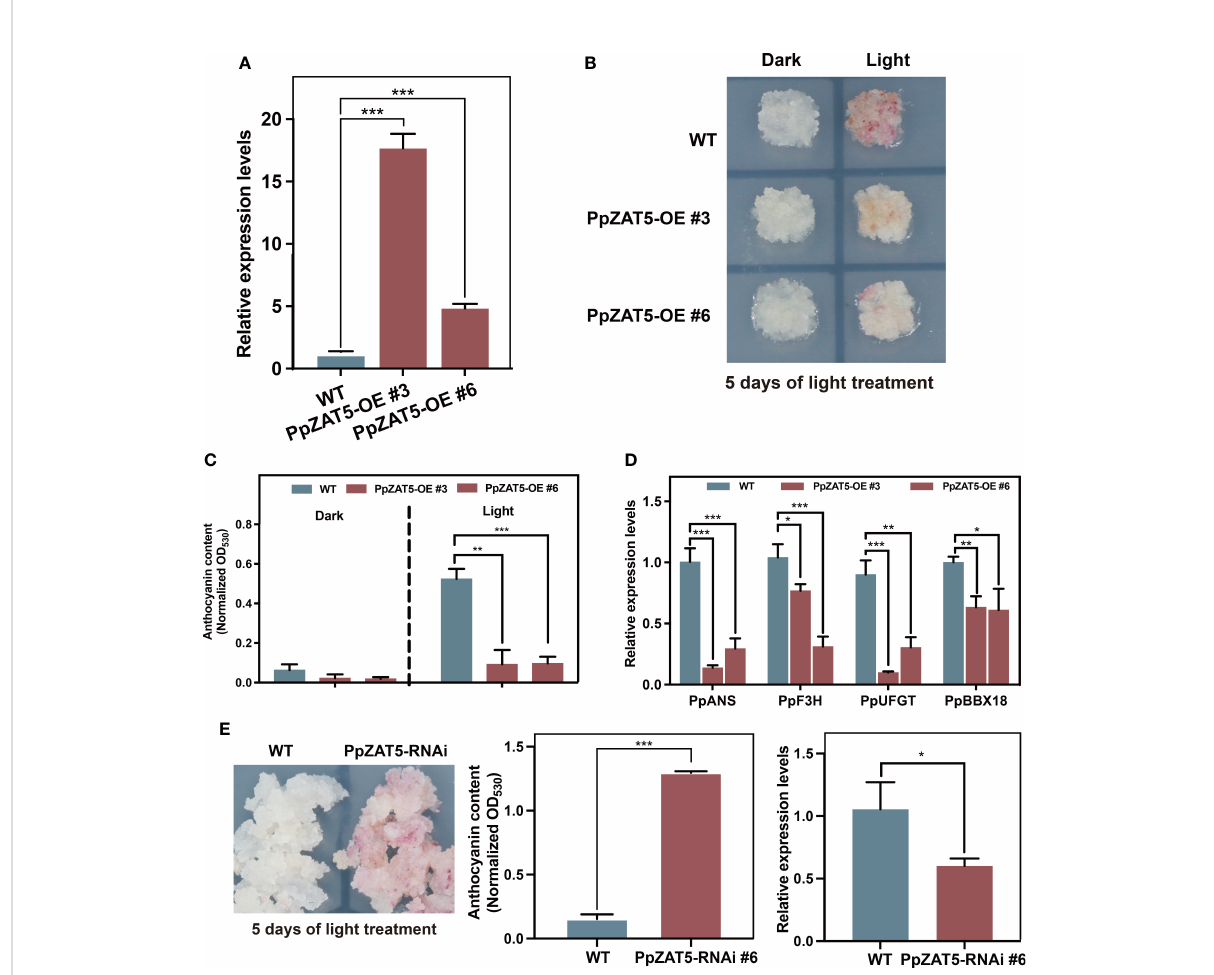
FIGURE 4 Overexpression and RNA interference (RNAi) of PpZAT5 in pear calli. (A) The expression level of PpZAT5 in overexpression pear calli. (B) Less anthocyanin accumulate in PpZAT5-OE pear calli. The pear calli were incubated under strong light at 17°C for 5 days. (C) Anthocyanin contents in PpZAT5-OE pear calli under dark and light treatment. (D) Expression levels of anthocyanin-related genes in pear calli under light treatment. (E) RNA interference (RNAi) of PpZAT5 promotes anthocyanin accumulation in pear calli. Error bars for anthocyanin contents and expression levels represent the standard deviation of three independent experiments. Asterisks indicate signi fi cant differences (two-tailed Student ’ s t -test, *P < 0.05, **P < 0.01, ***P <